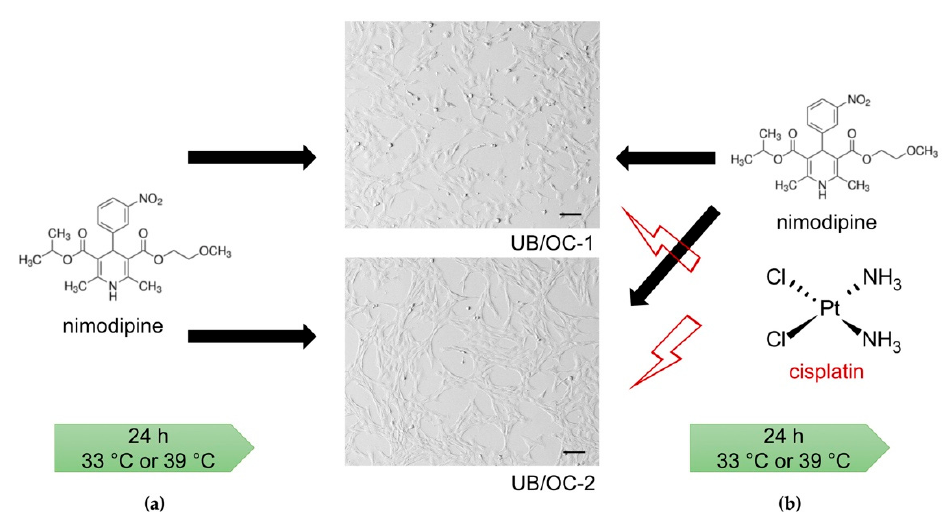
Figure 9. Scheme of nimodipine and cisplatin treatment. To investigate the protective effect of nimodipine on cisplatin-associated ototoxicity UB/OC − 1 and UB/OC − 2 were pre-treated with different concentrations of nimodipine for 24 h ( a ). Afterward, stress was induced by 20 µ M, 50 µ M, and 100 µ M cisplatin while the same amount of nimodipine was added again. Experiments were performed 24 h after the cell stress was triggered ( b ). Microscopic images of UB/OC − 1 and UB/OC − 2 cells were created with Keyence BZ-X810 (Keyence, Neu-Isenburg, Germany).